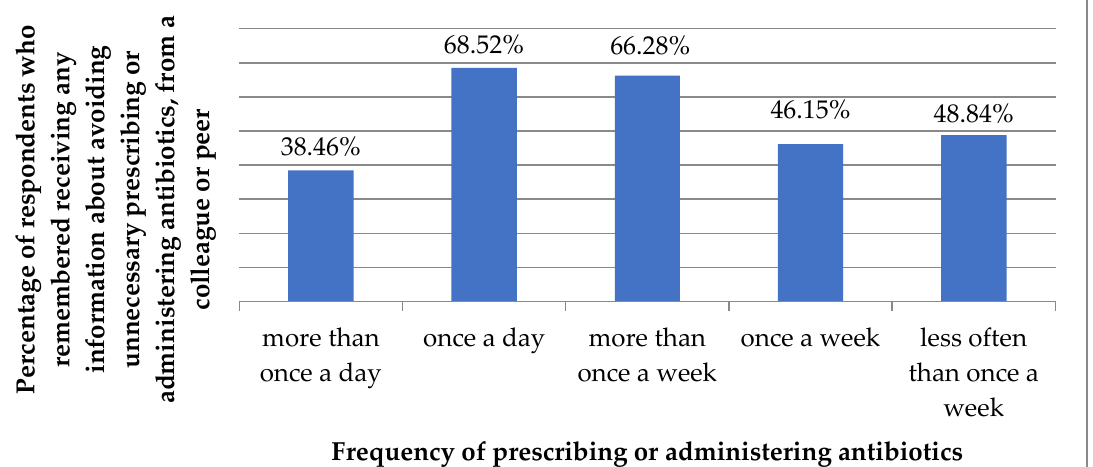
Figure 4. Percentage of respondents who remembered receiving information about avoiding unnecessary prescribing or administering or dispensing of antibiotics from a colleague or peer, by the frequency of prescribing or administering antibiotics.